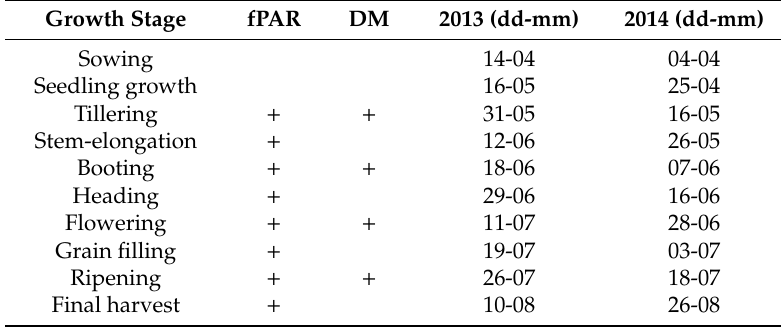
Table 1. Time schedule of measurements of fraction of PAR at the soil surface (fPAR) and aboveground dry matter (DM) at di ff erent calendar dates and growth stages for the field trials in 2013 and 2014. Growth Stage